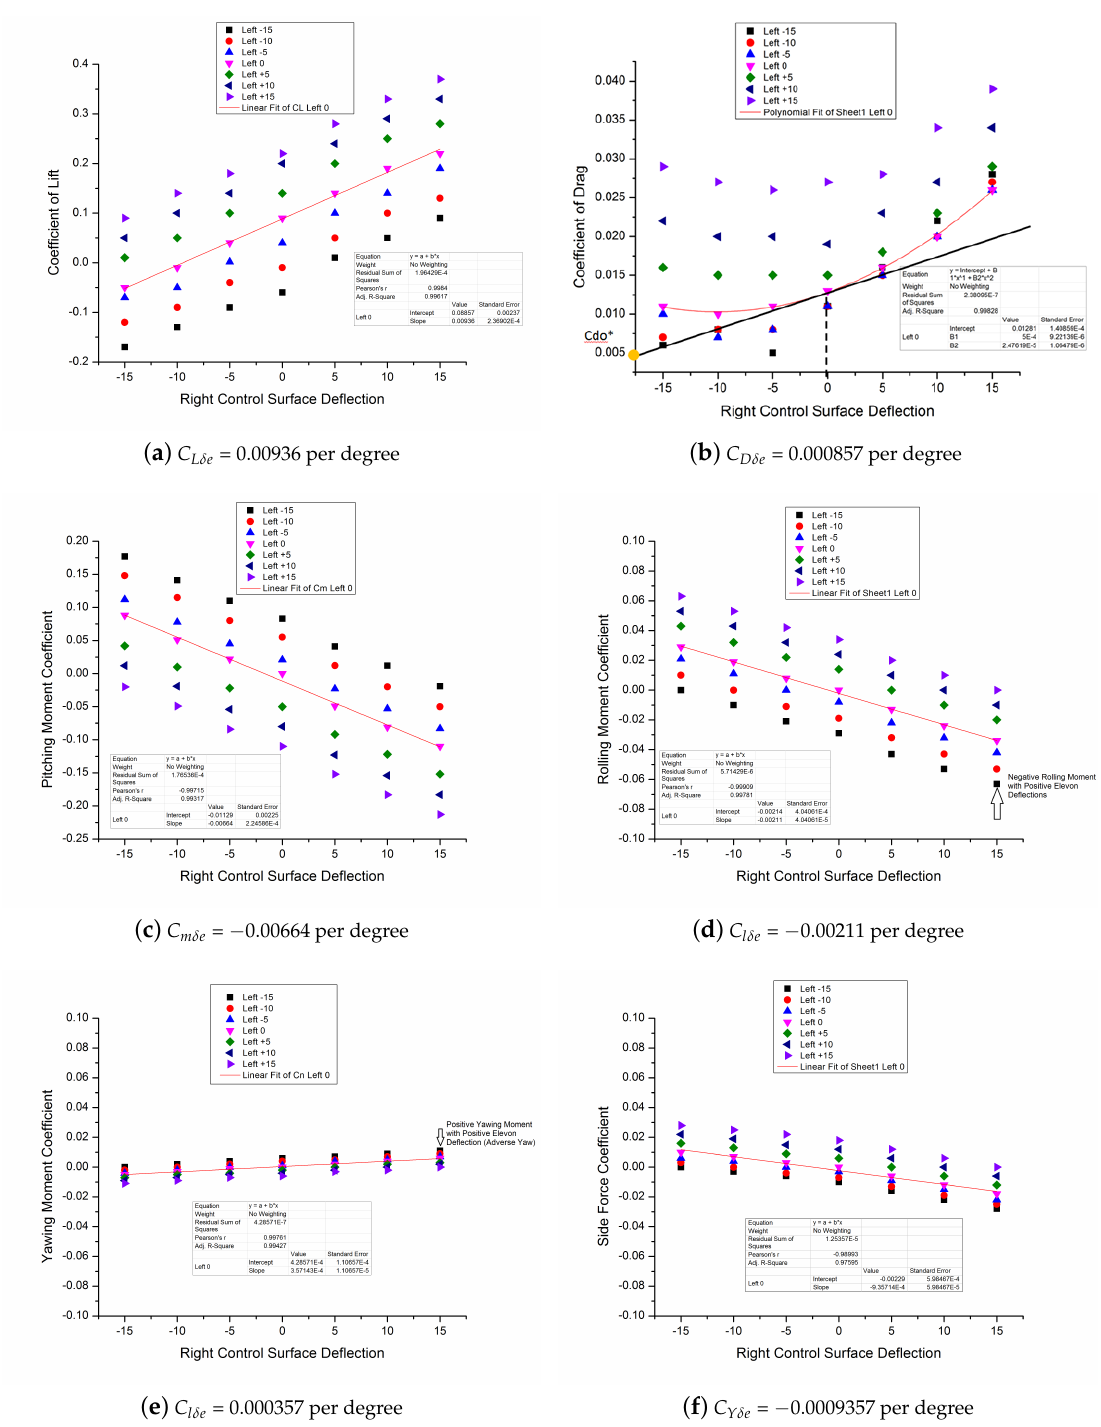
Figure 7. Computationally calculated elevon control derivatives. Derivatives are calculated from linear curve fit passing from zero control